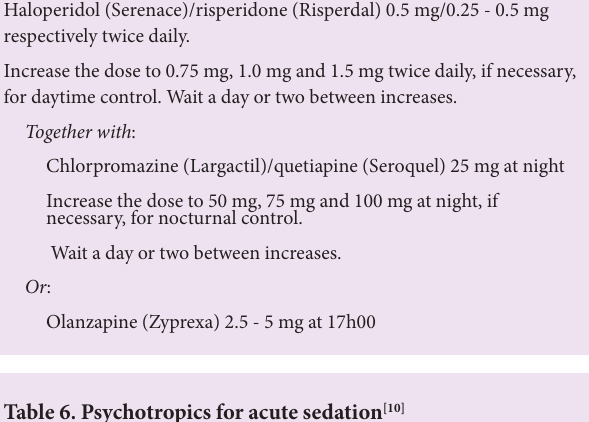
Table 5. Example of a neuroleptic regimen [10] Haloperidol (Serenace)/risperidone (Risperdal) 0.5 mg/0.25 - 0.5 mg respectively twice daily.